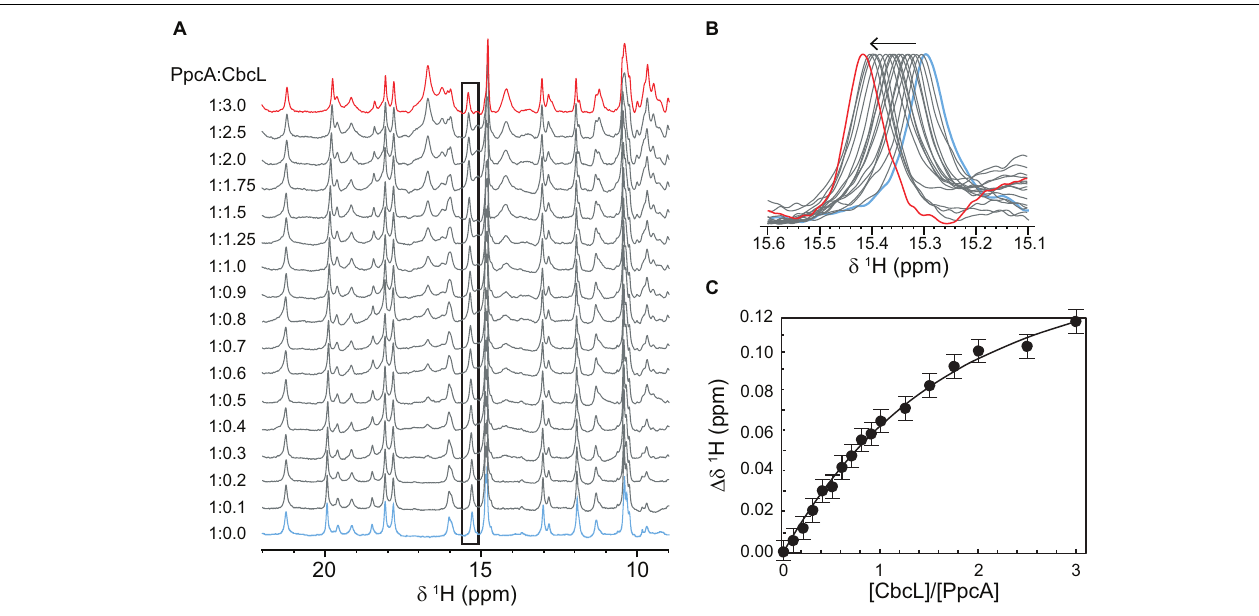
FIGURE 6 | Binding studies between cytochromes PpcA and CbcL followed by NMR chemical shift perturbation experiments. (A) 1D 1 H NMR spectra of PpcA acquired with increasing amounts of CbcL (ratio PpcA:CbcL indicated on the left side of each spectrum). Spectra were acquired at 25 ◦ C with 50 µ M of PpcA in 10 mM sodium phosphate pH 8. (B) Expansion of the region containing the most affected heme methyl signal 18 1 CH 3I . (C) Binding curve for CbcL and PpcA monitored by the chemical shift changes of heme methyl 18 1 CH 3I . The error bars represent estimated experimental errors. The solid line represents the fitting for a K d of 57 ± 9 µ